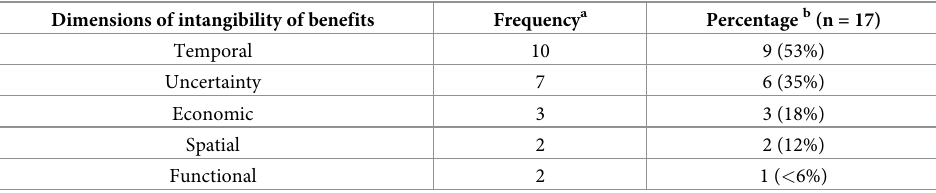
Table 3. Dimensions of intangibility of benefits associated with two-stage